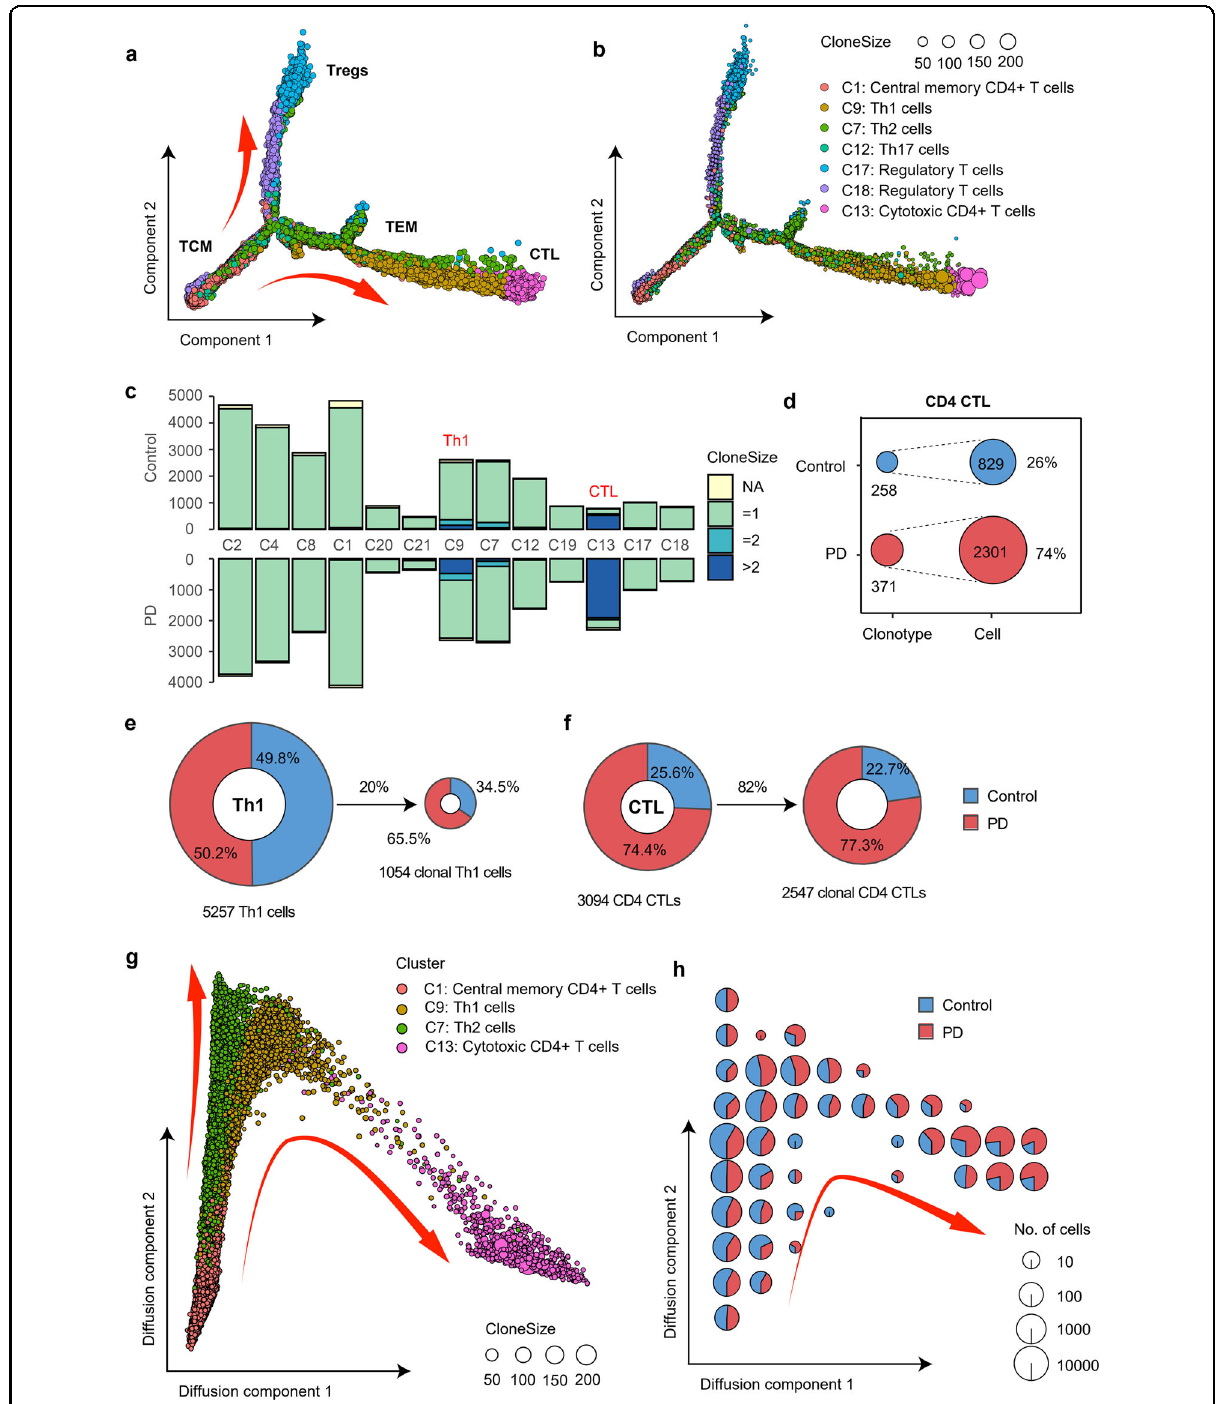
Fig. 4 Clonal expansion of CD4 + T cells. a Pseudo ordering of CD4 + T cells by monocle. b Pseudo ordering of unique clonotypes in each cluster. Each dot represents a unique clonotype in each cluster. The size of the dot re fl ects the clone size in each cluster. The color of the dot distinguishes different clusters. The coordinates of each clonotype were calculated by the average coordinates of the cells in that clonotype. c Bar plots showing the distribution of clonally expanded CD4 + T cells in the blood of PD patients and healthy controls. Fisher ’ s exact test was used to identify clusters enriched with clonal expansion of T cells from PD patients. d Clonotype diversity of CD4 CTLs in PD patients and healthy controls. Only samples with scTCR-seq data were counted. e Pie charts showing the sample composition of total cells and clonally expanded cells in Th1 cells (C9 cluster), respectively. Only samples with scTCR-seq were counted. f Similar to e , pie charts showing the sample composition of total cells and clonally expanded cells in CD4 CTLs (C13 cluster), respectively. g Pseudo ordering of T CM , Th1 cells, Th2 cells and CD4 CTLs in diffusion trajectories using diffusion maps. h Cell sample composition corresponding to the diffusion trajectory in g . The diffusion trajectory was divided into 10 × 10 square grids according to the horizontal and vertical coordinates, and each pie chart re fl ects the sample composition of cells in each grid